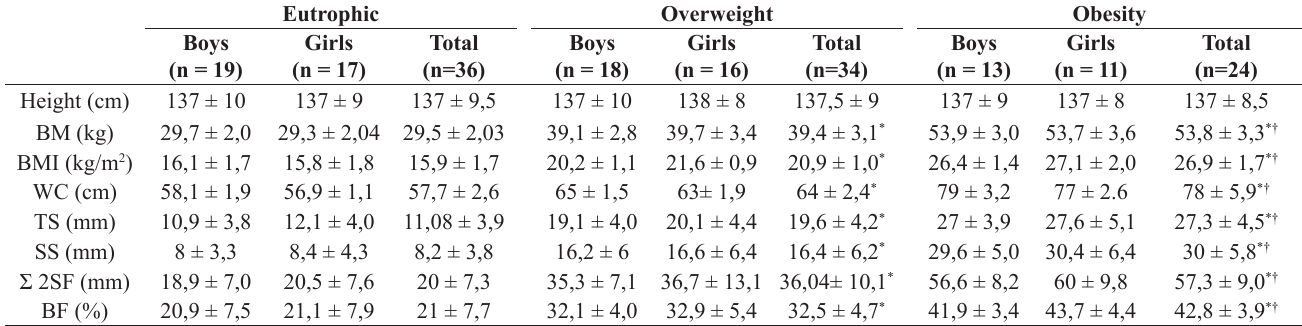
Table 2. Anthropometric measures and body